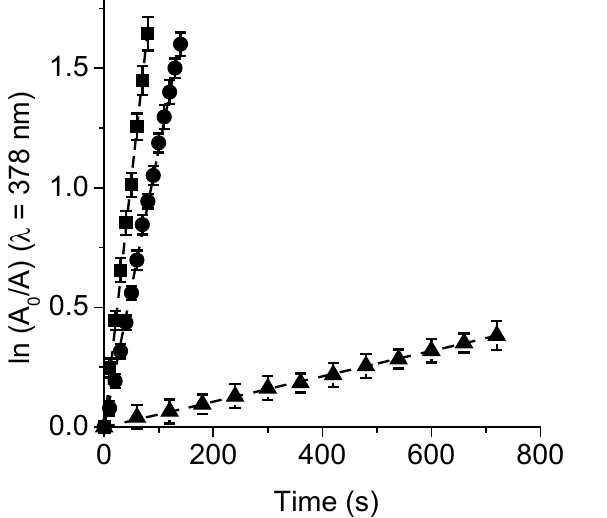
Figure 3. First-order plots for the photooxidation of DMA sensitized by ZnTMP ( (cid:4) ), ZnTEP ( • ) and PznTEP ( (cid:78) ) in DMF, λ irr = 455–800 nm.